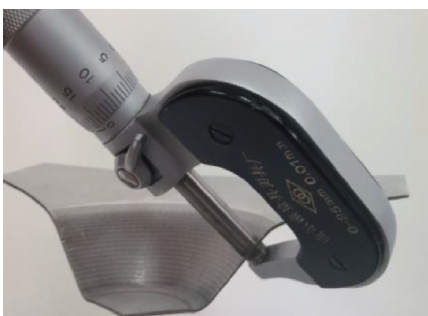
Figure 9: The measuring